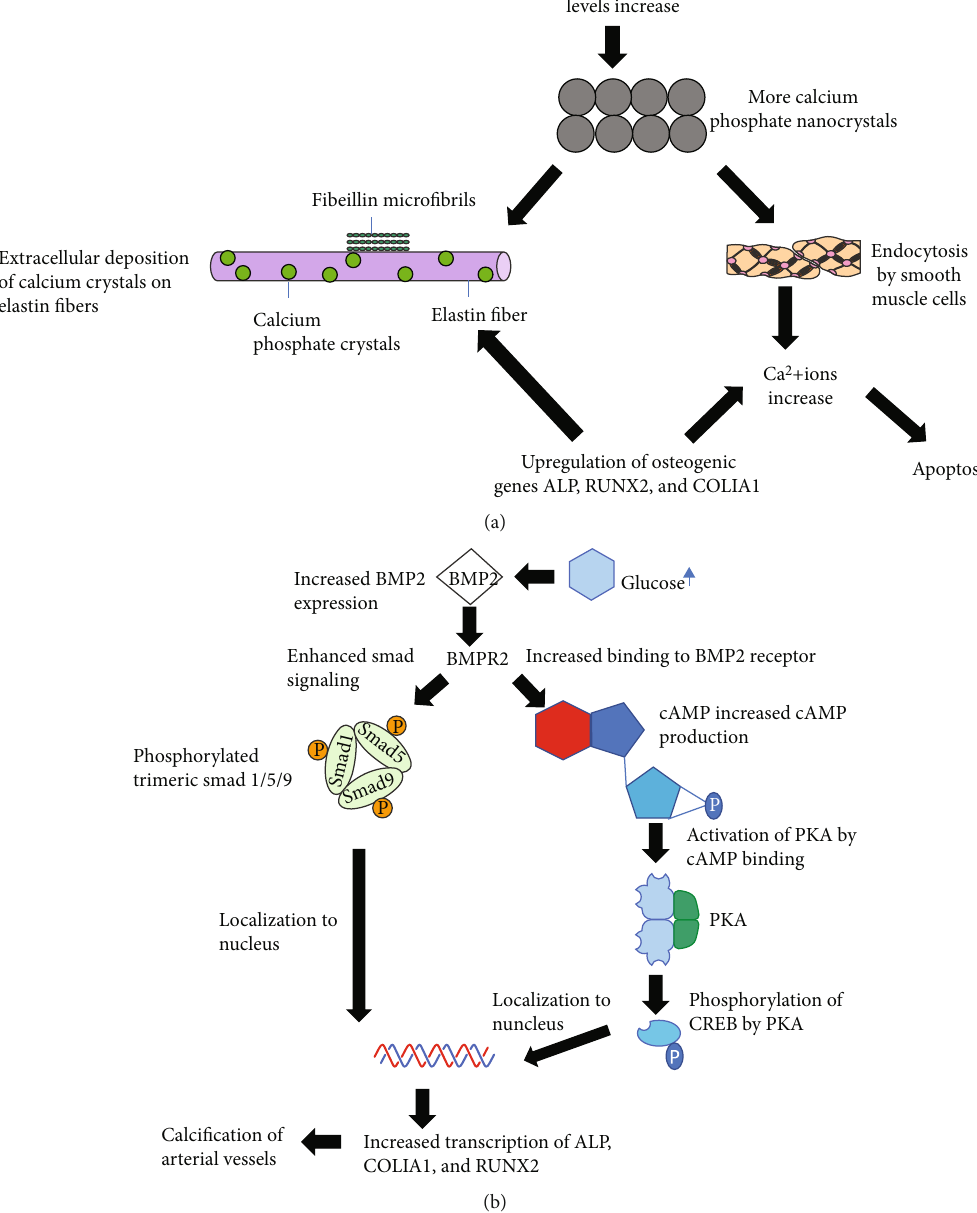
Figure 5: Two calci fi cation mechanisms of action that drive arterial vessel sti ff ening. (a) Calci fi cation process of arterial vessels induced by ageing or elevated blood glucose levels. (b) Molecular mechanism in which elevated glucose levels promote calci fi cation and higher baPWV